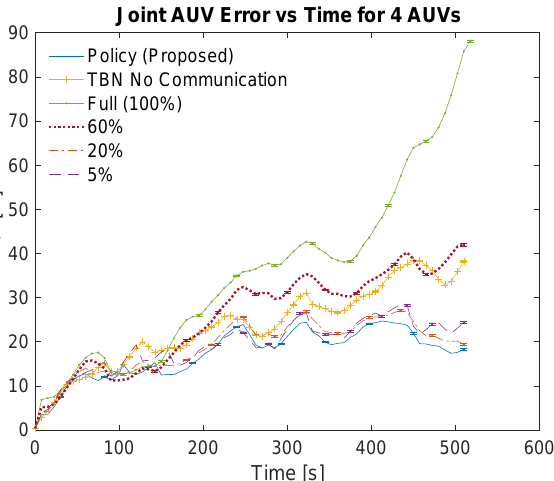
Figure 8. Simulation results for 2 AUVs using the planned policy, TBN without communication, and low bandwidth communication policies. Error bars show standard error of the mean.